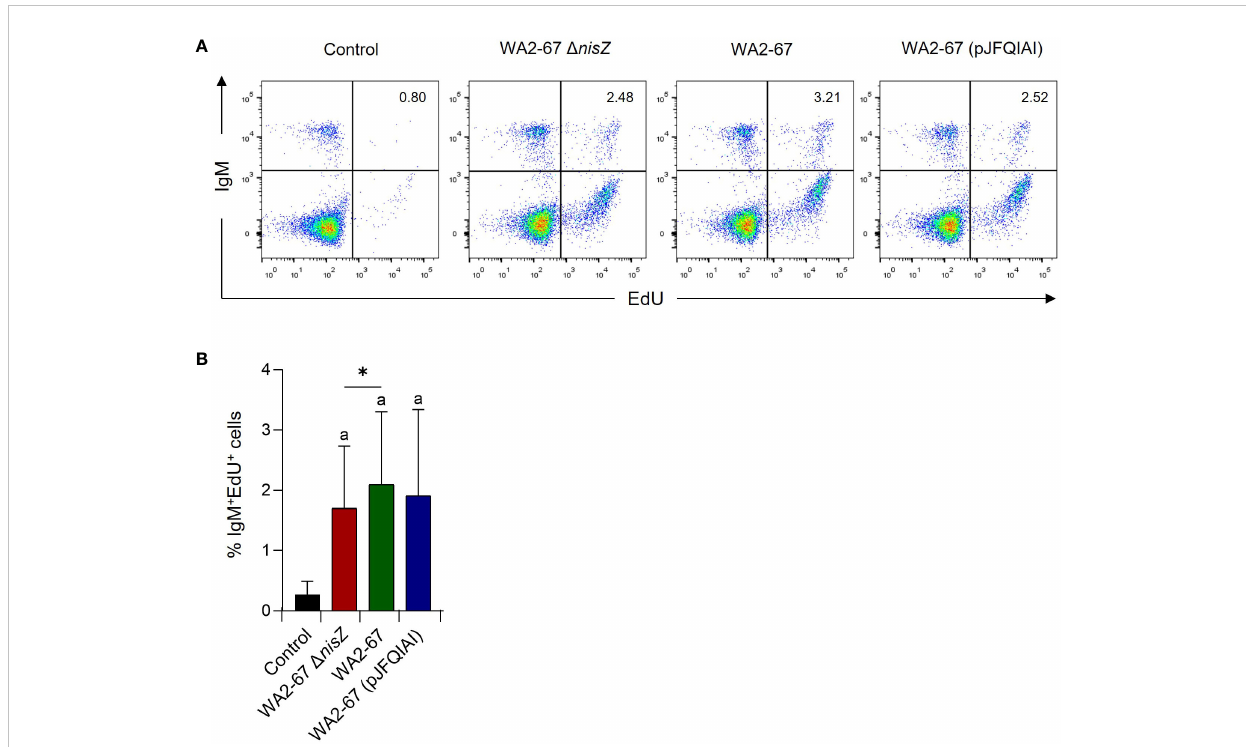
FIGURE 5 The lymphoproliferative effects of L. cremoris WA2-67 D nisZ , L. cremoris WA2-67 and L. cremoris WA2-67 (pJFQIAI) on B cells were determined by fl ow cytometry. For this, cells were stimulated with the bacteria at 20°C for 72 h, and subsequently splenic leukocytes were incubated with EdU for an additional 24 h. At that point, cells were labelled with anti-trout IgM-PE and the percentage of proliferating cells determined. Controls not treated with bacteria were also included. Representative dot plots (A) are included along with a graph (B) showing the percentage of live IgM + B cells in the lymphocyte gate (mean + SD; n=9). The letter (a) represents transcription levels signi fi cantly different than those observed in cells not exposed to the bacterial strains (control), while the asterisks indicate levels signi fi cantly different between bacterial treatments as indicated (* p ≤